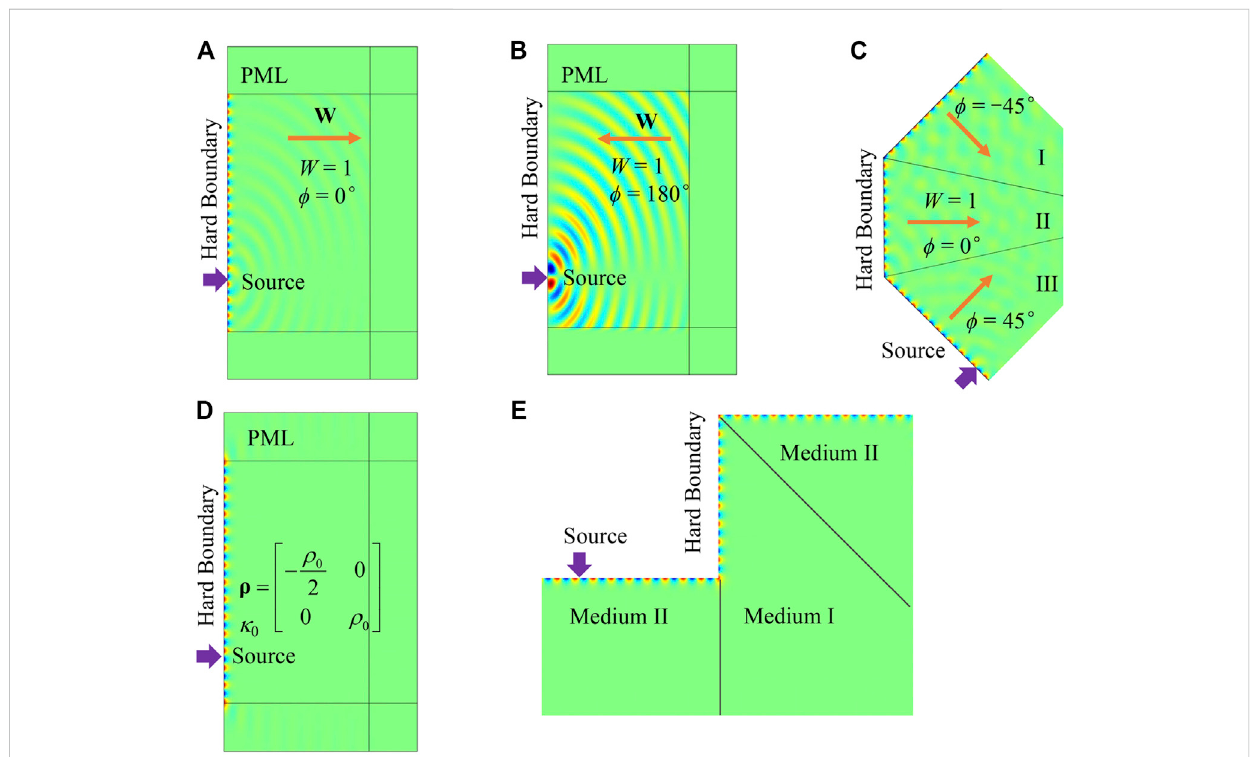
FIGURE 5 FEMsimulationsofsurfacewavesonhardboundariesofWillismedia(pressure fi eld). (A) Wpointsawayfromthesurface. (B) Wpointsto thesurface. (C) Waveguide for the edge wave with possible leaking into bulk. (D) Edge wave without bulk leaking using an anisotropic density. (E) Robust edge waveguide with sharper corners using an anisotropic